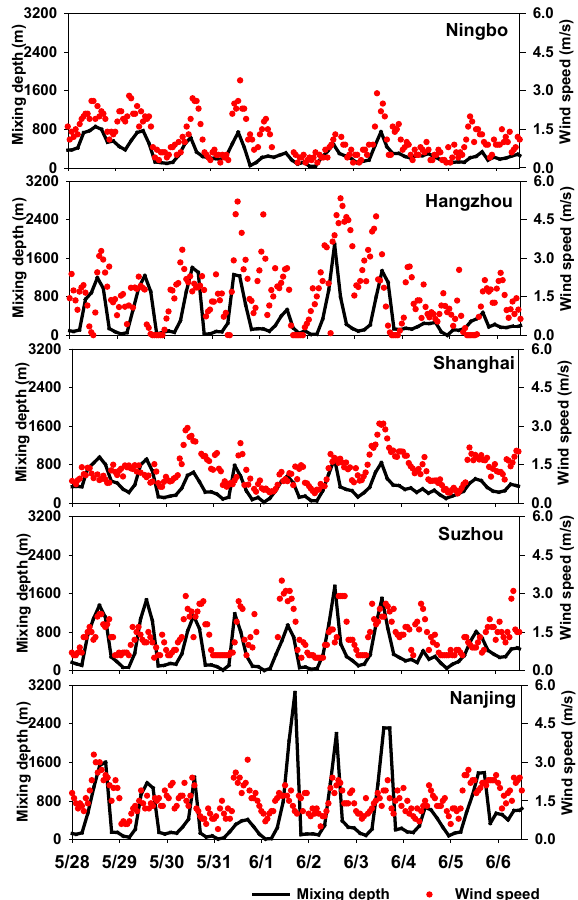
actually better for Nanjing site. Minimum 3 h mixing depth is as low as 5–30 m for five sites. For Shang- hai, Nanjing and Ningbo, the wind speeds are 0.2, 0.1 and 0.7 ms − 1 lower than those of Phase I, respectively. For Suzhou and Hangzhou they are 0.1 and 0.9 ms − 1 higher than those of Phase I. Ambient RH shows typi- cal diurnal variation (shown in Fig. 5), usually with